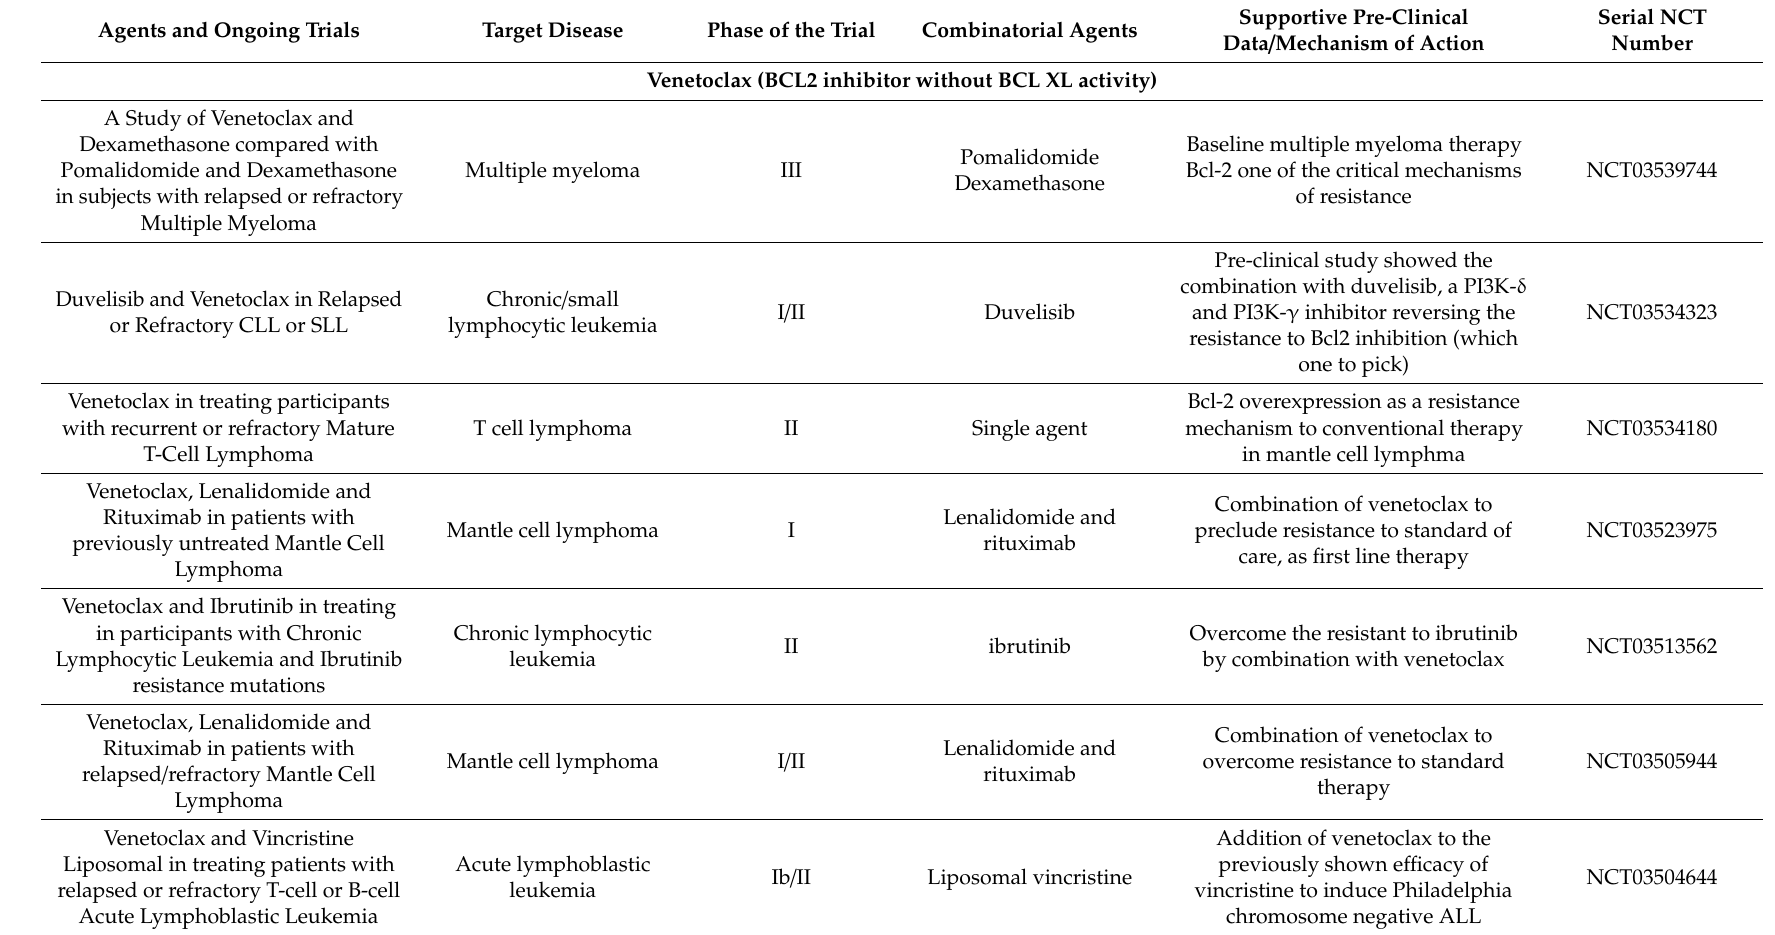
Table 2. Current ongoing clinical trials testing BCL2 inhibitors, ABT-199 (venetoclax), and ABT-263 (navitoclax), as a single agent or in